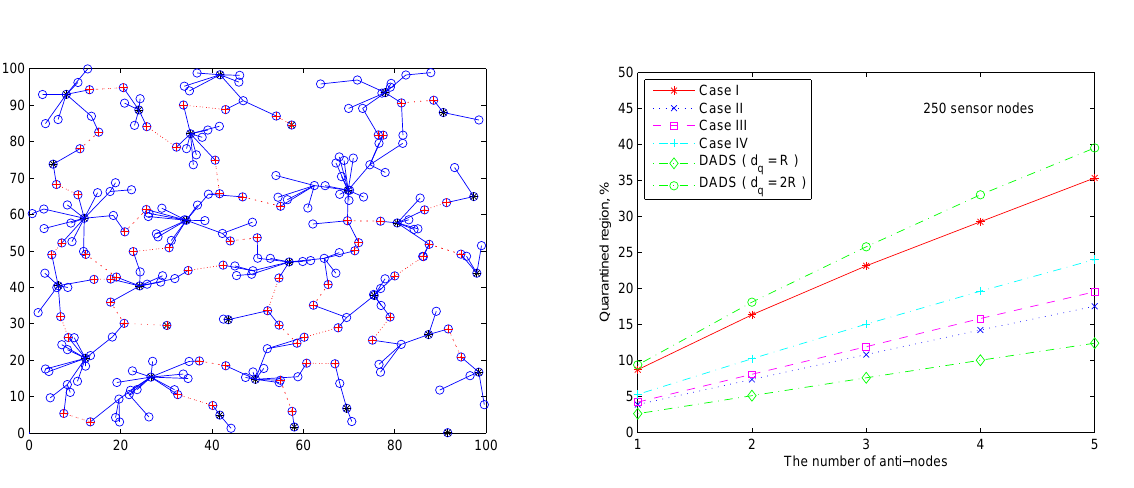
Figure 20. A random network of 250 sensors deployed based on Gaussian distribution with sensor deployment strategy I (left); the average percentage of the quarantine region